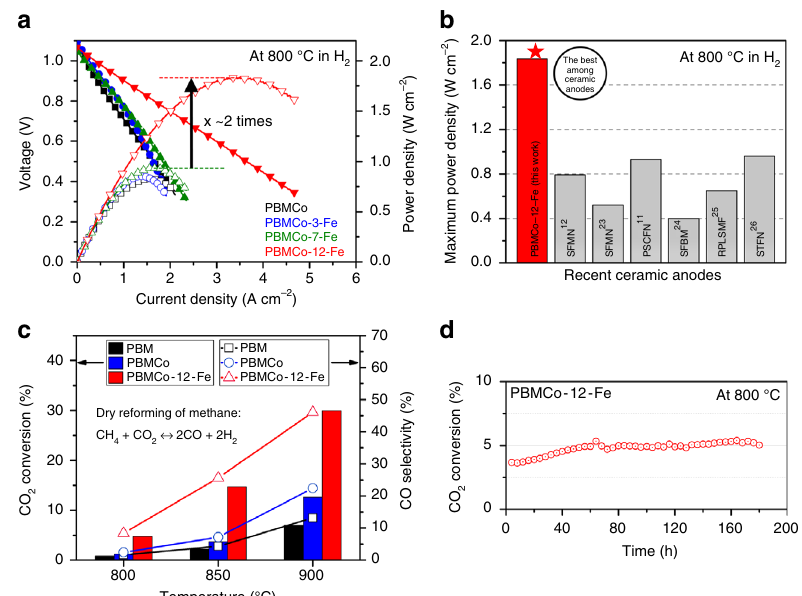
Fig. 4 Catalytic properties. a I – V curve and the maximum power densities of the PBMCo- x -Fe samples. b Comparison of the maximum power density at 800 °C in H 2 from the present work and other reported studies 11,12,23 – 26 . c Conversion of CO 2 and selectivity of CO measured for PBM, PBMCo, and PBMCo-12-Fe in dry reforming of methane at various temperatures. d Time-dependence of CO 2 conversion for PBMCo-12-Fe in dry reforming of methane at 800